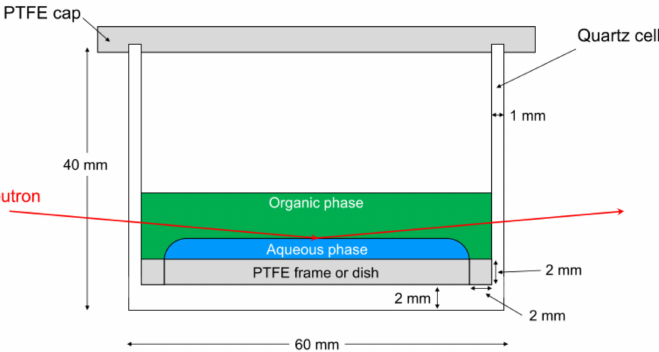
Figure 1. Schematic diagram of the new sample cell for measuring NR. Photos of a new type of cell with the PTFE frame are shown in Figure